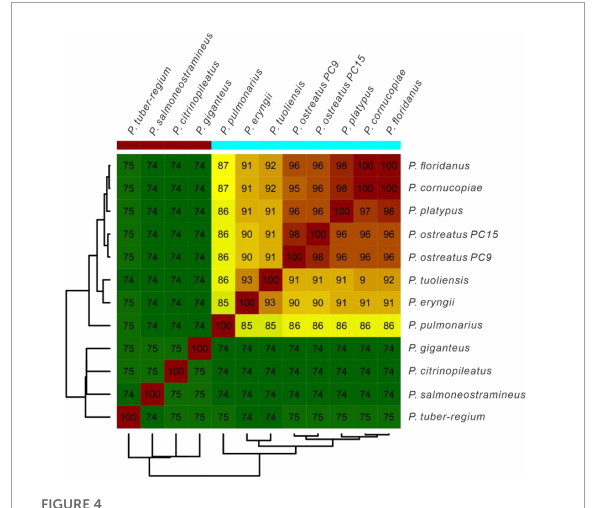
FIGURE4 The average nucleotide identity (ANI) values based on the fastANI algorithm generated matrix for Pleurotus genomes . The clustering was constructed using Euclidean distance matrix.